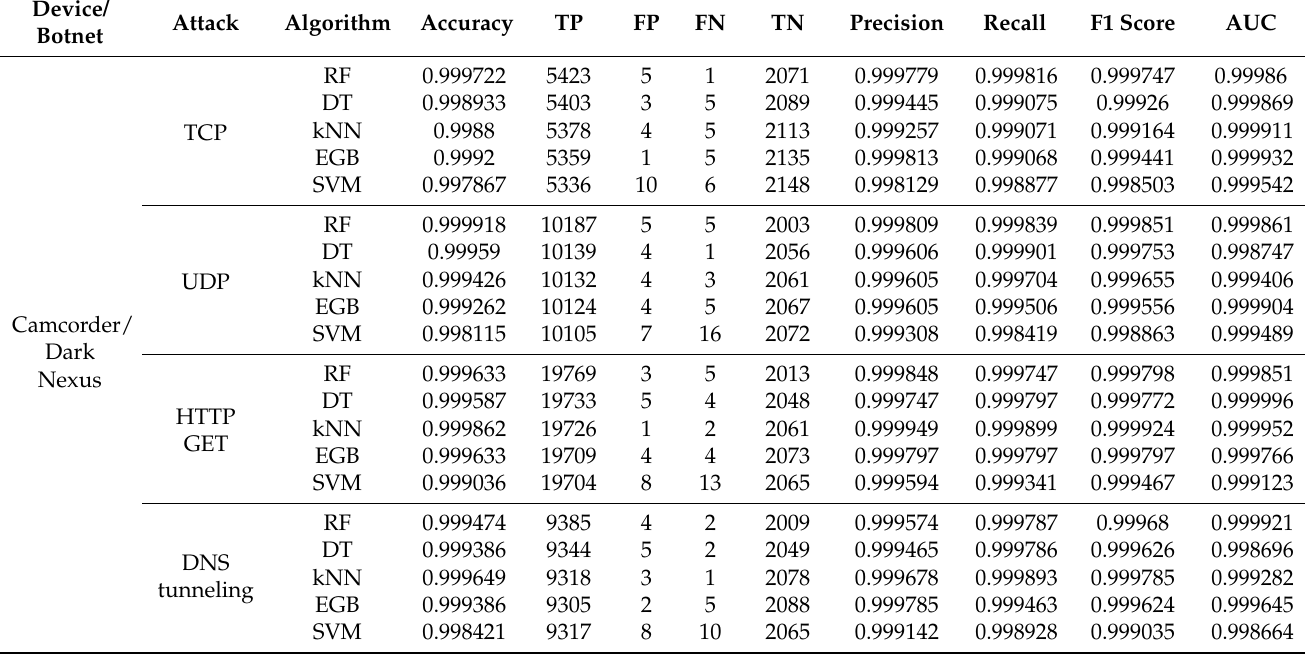
Table 19. Classification results (camcorder—Dark